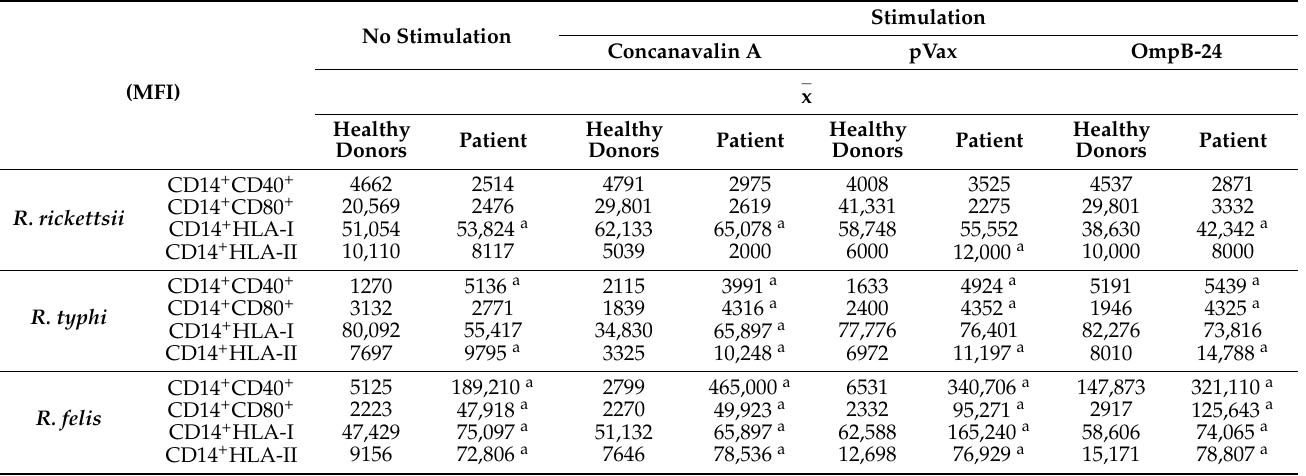
Table 3. Mean Fluorescence Intensity (MFI) of CD40, CD80, MHC-I, and MHC-II in macrophages − x refers to the statistical (CD14+).